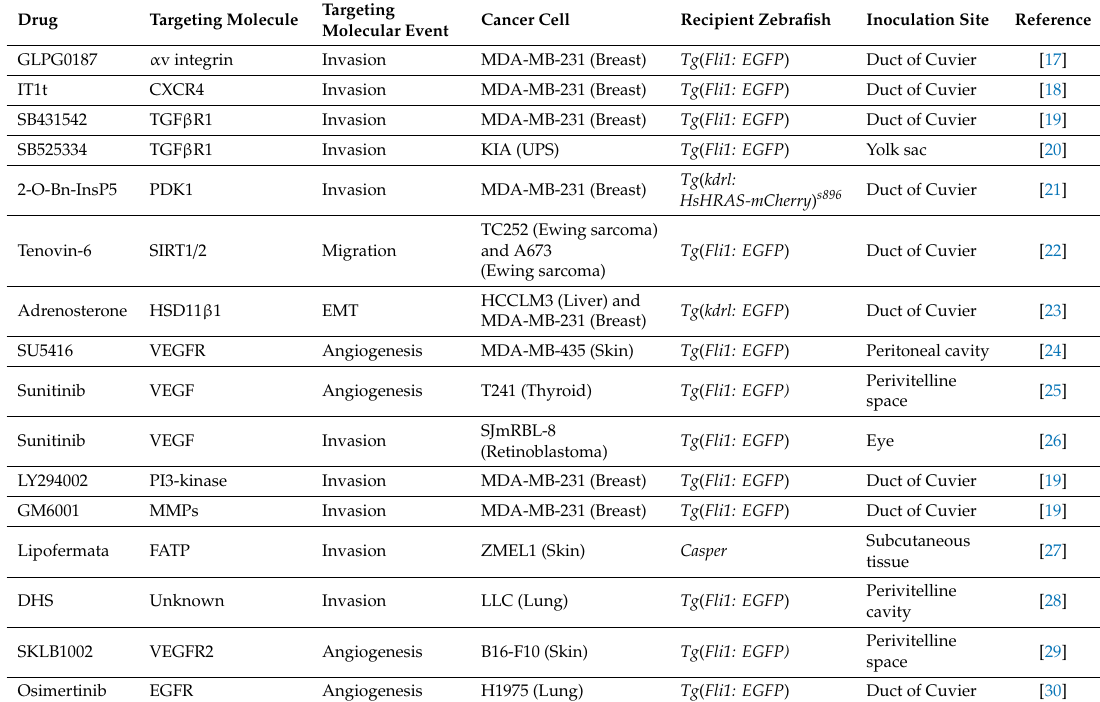
Table 1. A list of the anti-metastatic drugs identified in zebrafish xenograft